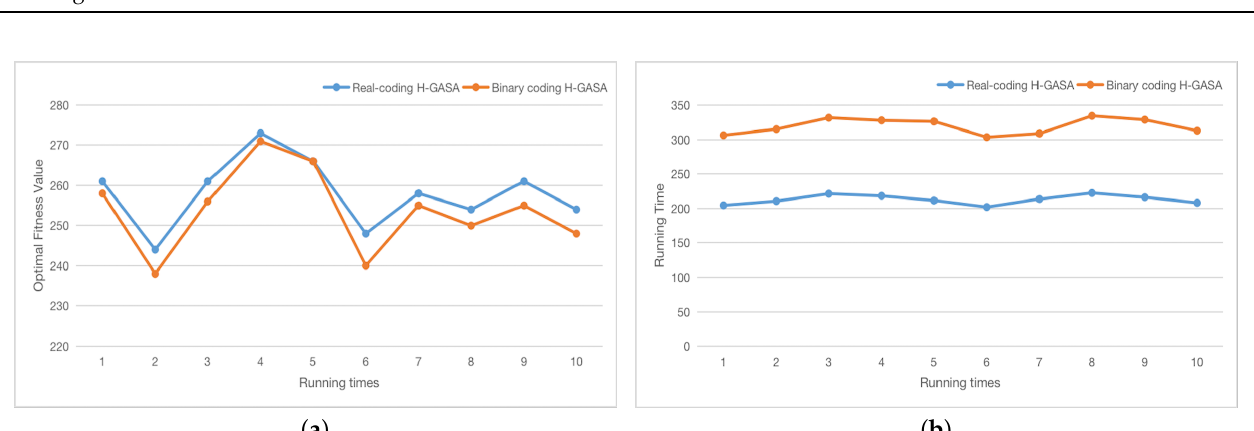
Figure 8. Comparison of H-GASA results based on different encoding methods: ( a ) Comparison of optimal fitness values of H-GASA based on different coding methods. ( b ) Comparison of running time of H-GASA based on different coding